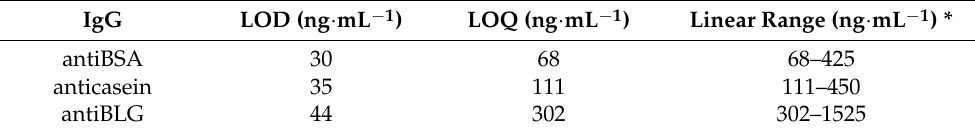
Table 2. Comparative table of limits of detection reported by recent optical bioanalytical develop- ments in the scientific literature for sensing specific IgGs.